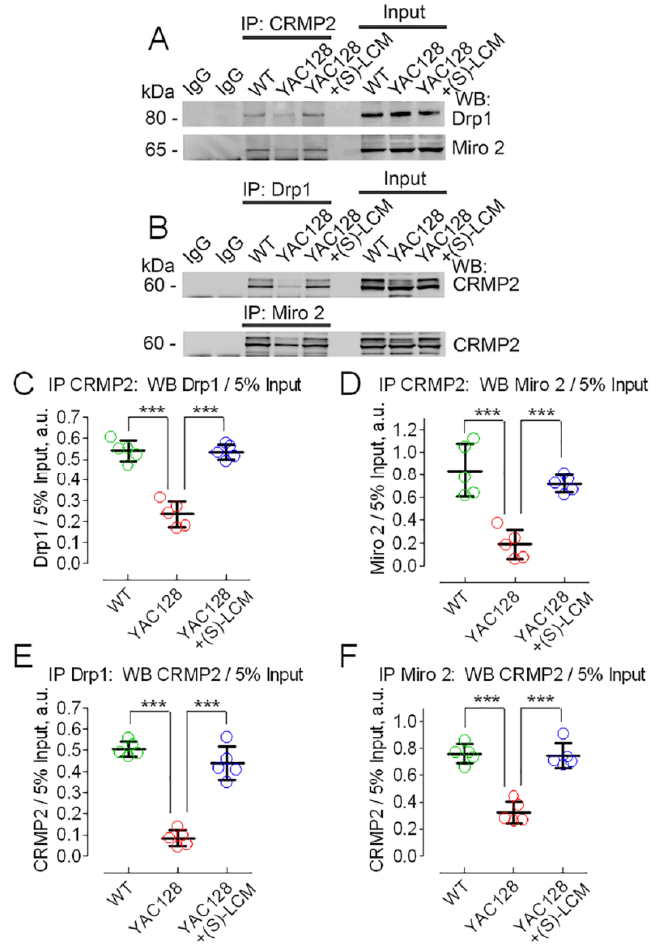
Figure 4. Hyperphosphorylation of CRMP2 in neurons from YAC128 mice correlated with decreased CRMP2 binding to Drp1 and Miro 2, whereas (S)-lacosamide ((S)-LCM) prevented disruption of CRMP2 binding to these proteins. ( A ), immunoprecipitation (IP) with anti-CRMP2 antibody followed by Western blotting (WB) with anti-Drp1 and anti-Miro 2 antibodies; ( B ), IP with anti-Drp1 and anti-Miro 2 antibodies followed by WB with anti-CRMP2 antibody. Where it is indicated, YAC128 neurons were treated with 10 µM of (S)-LCM for the last 7 days prior to analysis. The input was 5% of the total protein used in the pull-down procedure. ( C – F ), densitometry data. Drp1, Miro 2, and CRMP2 were normalized by the corresponding 5% input value. Data are mean ± SD. *** p < 0.001 comparing FVB/NJ neurons and YAC128 neurons; comparing YAC128 neurons with and without (S)-LCM treatment, N = 5 separate, independent experiments.